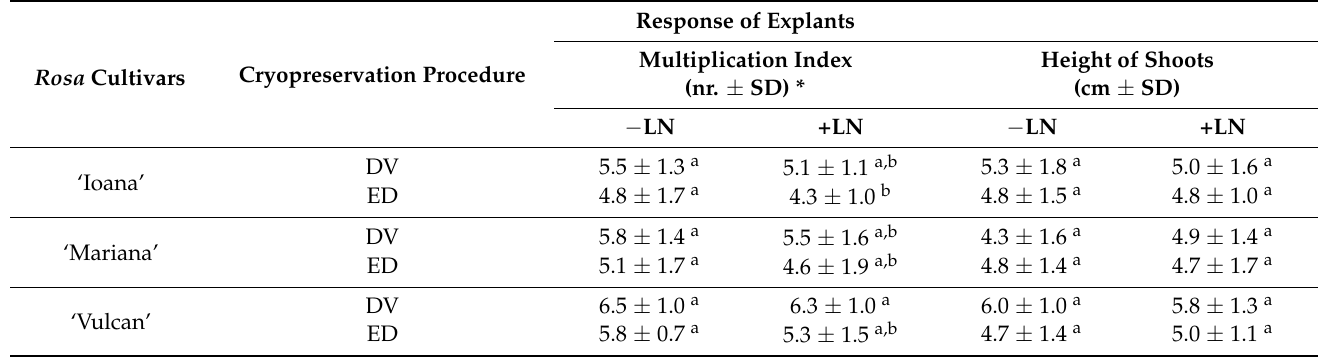
Table 3. Effects of liquid nitrogen storage on the multiplication index and the height of shoots from